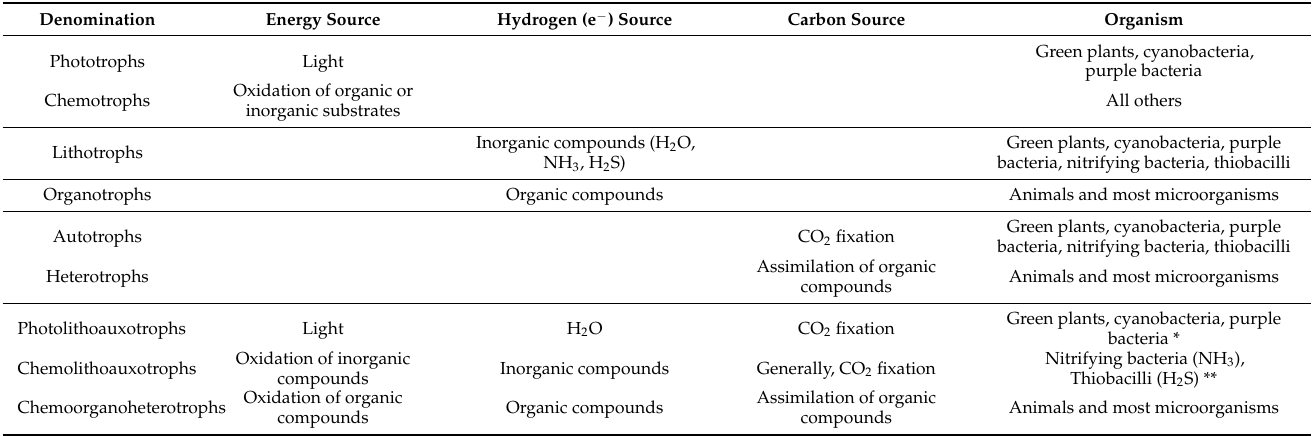
Table 2. Classification of living organisms according to their nutritional needs and the sources of energy, hydrogen (electrons) and carbon used (modified from